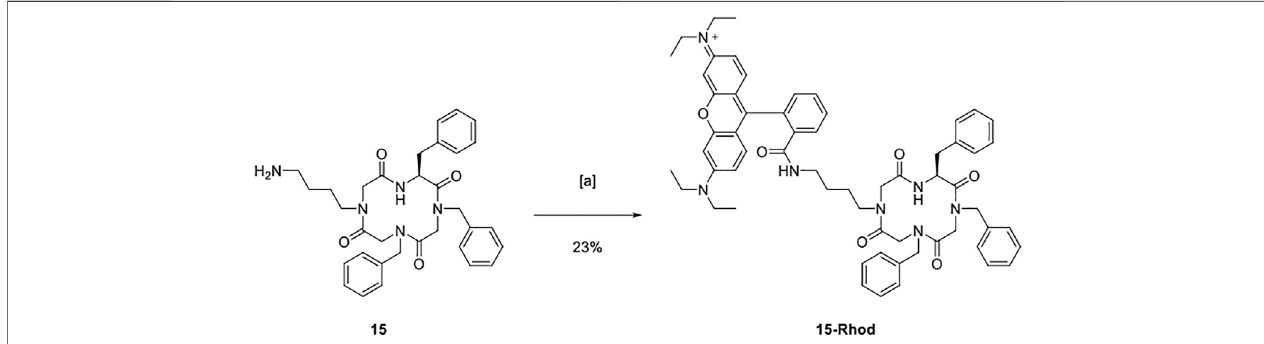
SCHEME 1 | Synthetic approach for the assembly of linear precursors on solid support. [A] : Fmoc-protected amino acid, N,N ′ -diisopropylethylamine (DIPEA), N-methyl-2-pyrrolidone (NMP), 21 ° C, 16 h; [B] : piperidine, dimethylformamide (DMF), 21 ° C, 3 × 5 min; [C] : Fmoc-protected amino acid, N,N ’ -diisopropylcarbodiimide (DIC),hydroxybenzotriazole,NMP,21 ° C,4h; [D] :bromoaceticacid,DIPEA,DMF,21 ° C,1h; [E] :amine,DMF,21 ° C,1 – 16h; [F] :bromoacetic acid,DIC, DMF,21 ° C,30 min; [G] : hexa fl uoroisopropanol, methylene chloride, 21 ° C, 16 h.